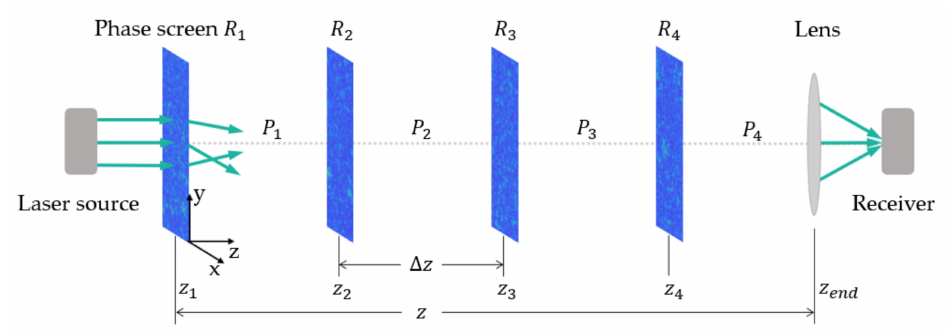
Figure 1. Schematic description of the beam propagation model of the UWOC